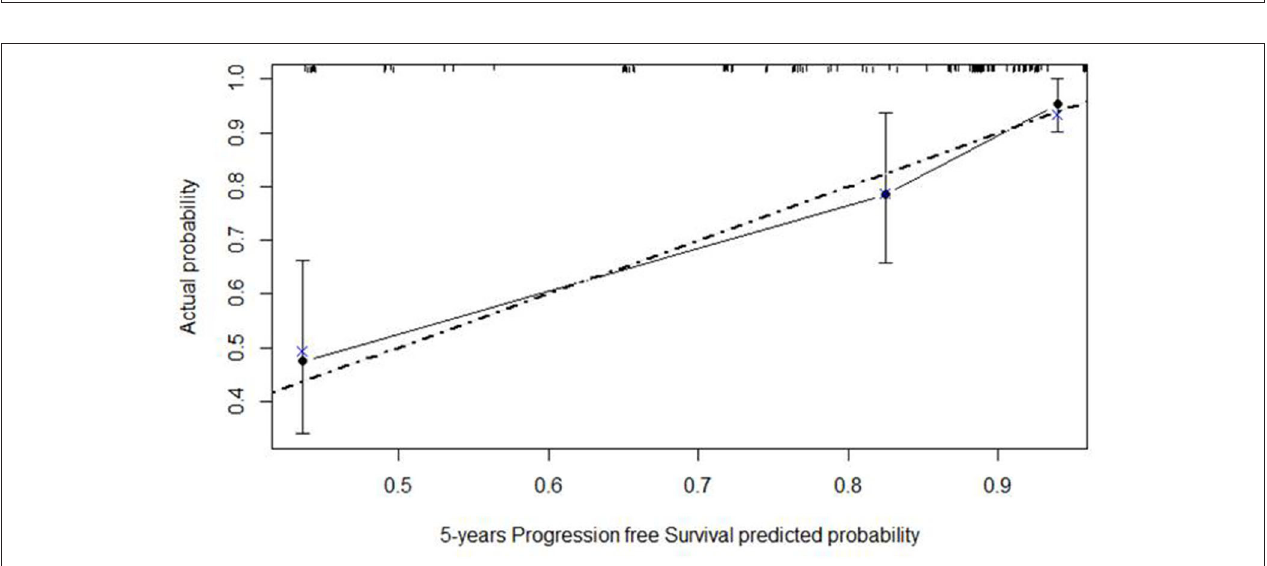
FIGURE 8 | Calibration plot of the Cox regression model of progression-free survival at five years of nomogram 2. The dashed gray line represents the “ideal” line of perfect correspondence between predicted and observed survival, the points represent the predicted “apparent” survival, and the vertical bars represent the 95% confidence intervals. The Xs represent bootstrap estimates corrected with n = 500